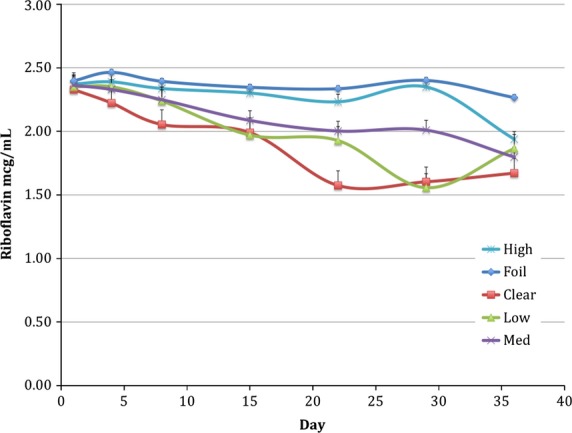
Rb degradation in packaging treatments, Low (0.6% TiO2), Med (1.3% TiO2), and High (4.3% TiO2), compared to foil-wrapped and clear packaging over a 36-day period.1 Average of data in both Block A and Block B. 1Exposure to light in hours: day 1 = 23.5, day 4 = 84, day 8 = 191, day 15 = 359, day 22 = 527, day 29 = 696, day 36 = 864.